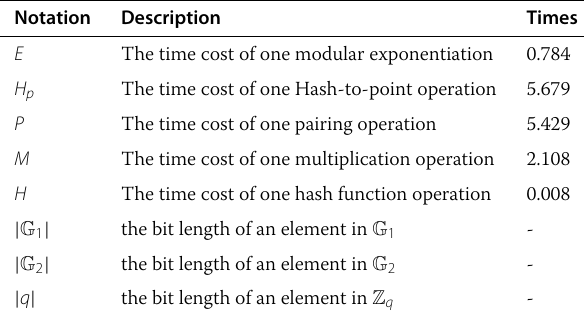
Table 2 Symbols and execution times(ms)